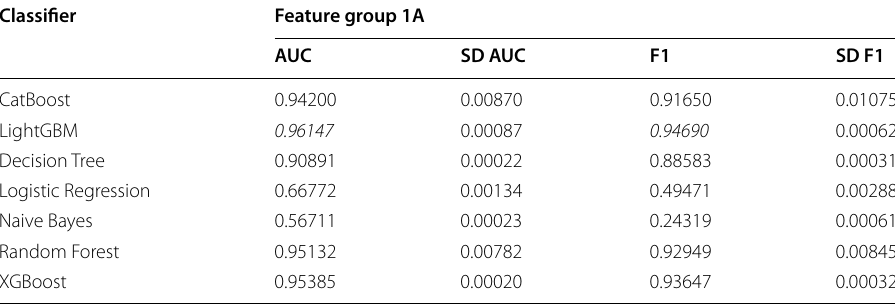
Table 25 Mean performance of 7 classifiers in terms of AUC and F1-score on datasets with features from feature group 1A